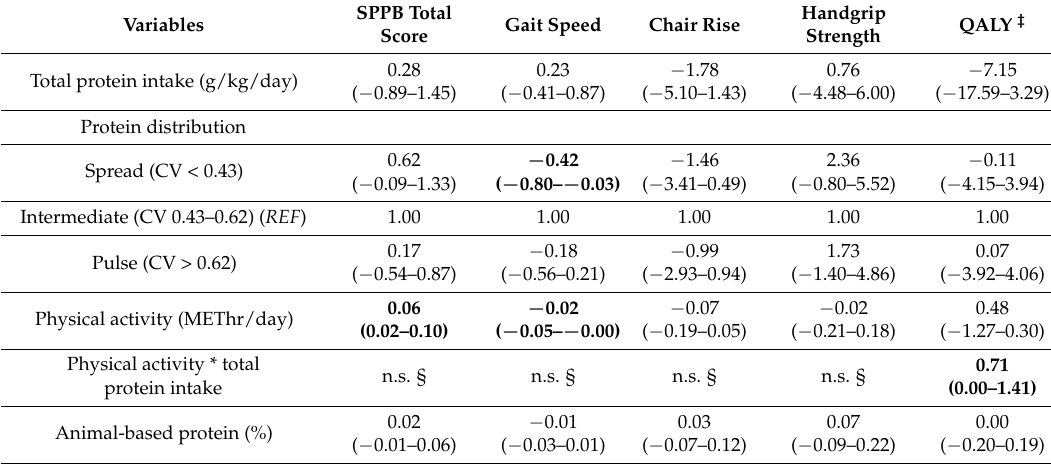
Table 2. Adjusted linear regression model * for SPPB total score, SPPB gait speed (s), SPPB chair rise (s), handgrip strength (kg) and